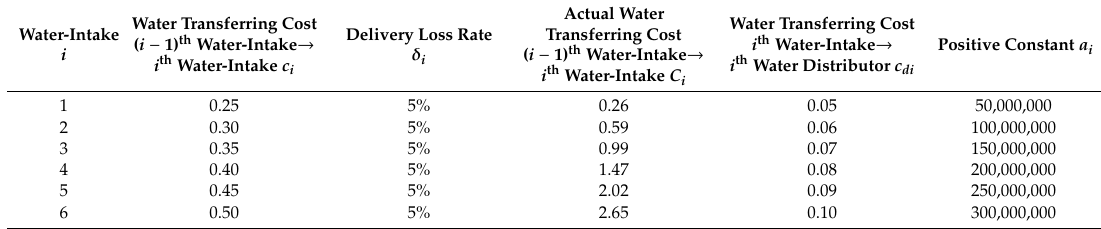
Table 2. Parameters in the IBWT vertical supply chain for the numerical analysis.